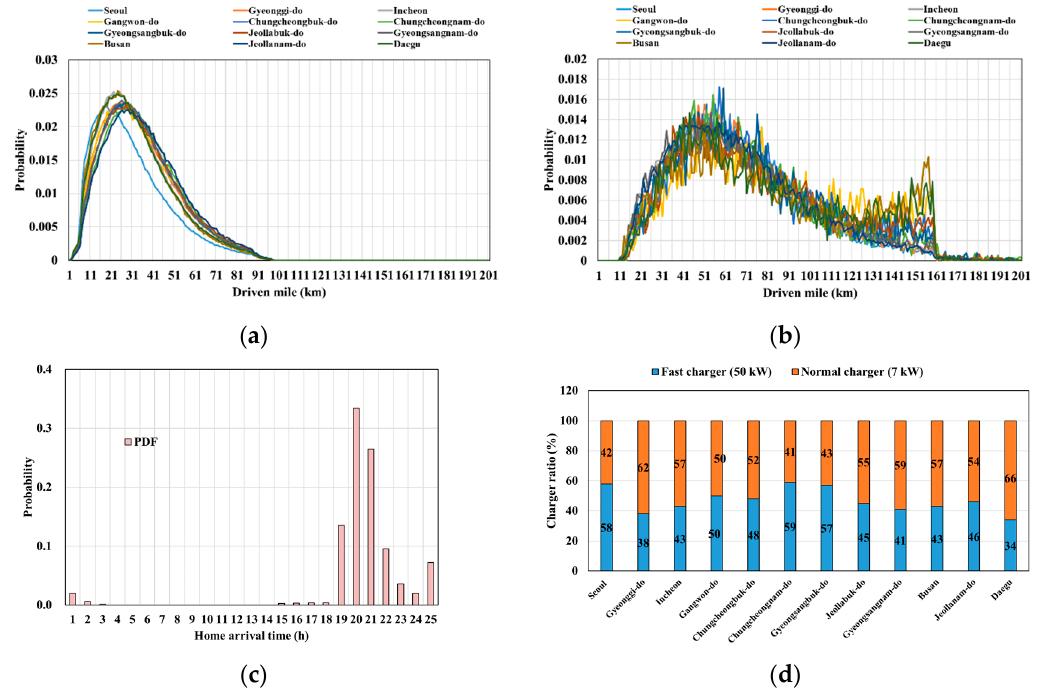
Figure 9. Statistics for PEV charging demand modeling: ( a ) Private vehicle daily driving distance; ( b ) Commercial vehicle daily driving distance; ( c ) Home arrival time; ( d ) Charger for commercial vehicle.